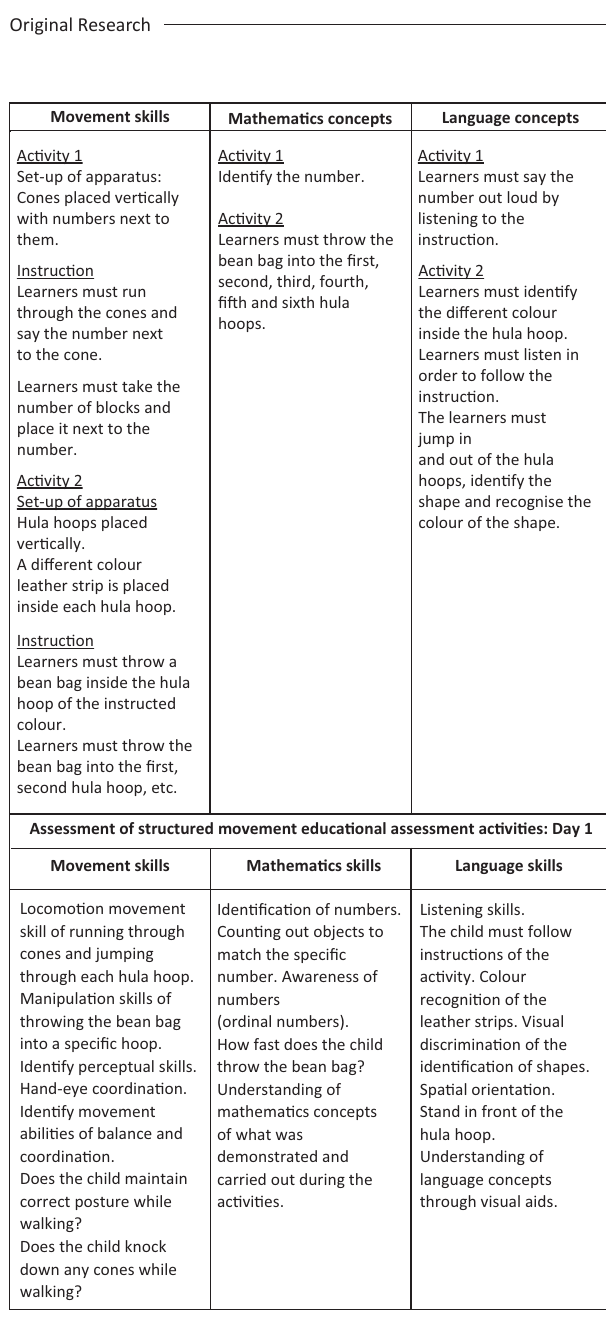
FIGURE 2: The structured movement educational assessment activities for Day